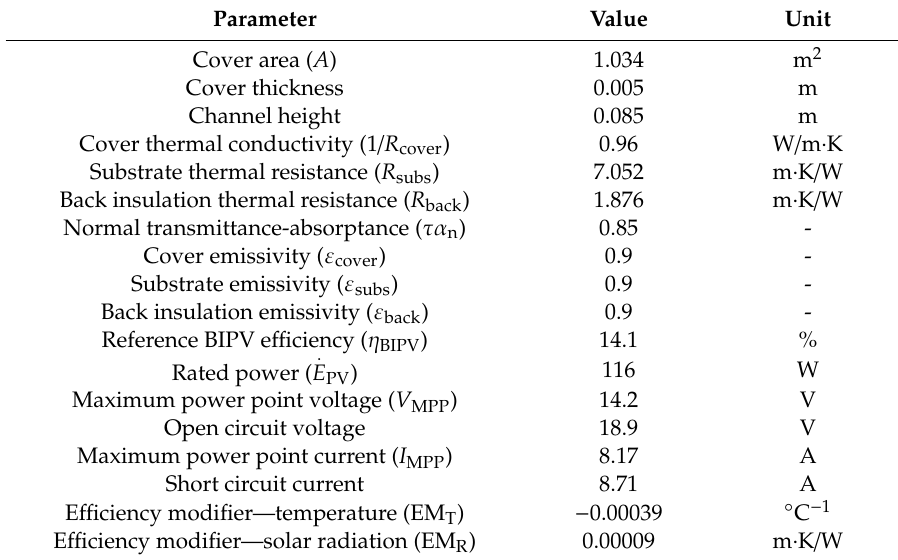
Table 2. Parameters of the target BIPV